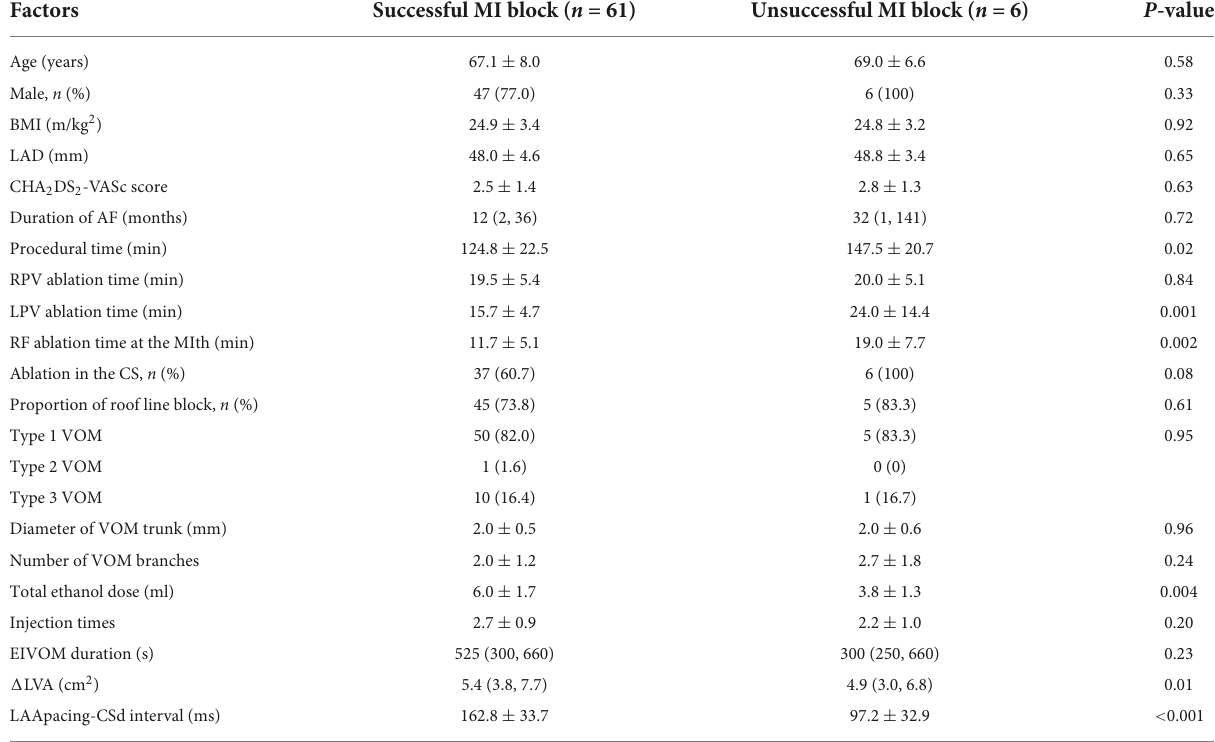
TABLE 3 Comparison between successful and unsuccessful MIth block in the EIVOM first approach.